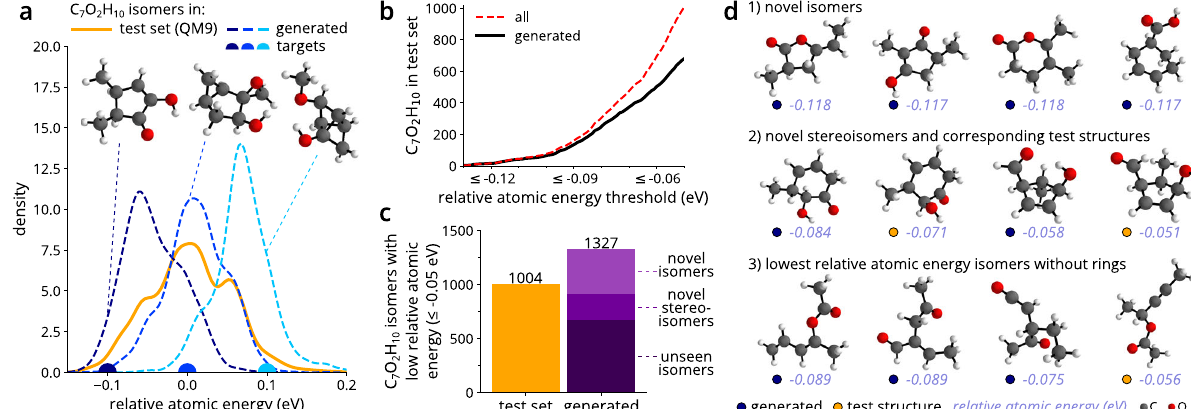
Fig. 4 Discovery of low-energy isomers for an unseen composition. We sample C 7 O 2 H 10 isomers with cG-SchNet conditioned on atomic composition and relative atomic energy (see text for details), where the training dataset was restricted to contain no C 7 O 2 H 10 conformations. a The distribution of the relative atomic energy for C 7 O 2 H 10 isomers in the test set (orange) and for three sets of isomers generated with cG-SchNet (blue curves) when targeting the composition C 7 O 2 H 10 and three different relative atomic energy values as marked with color-matching dots on the x -axis. The generated isomer closest to the respective target is depicted above each curve. b The absolute number of C 7 O 2 H 10 isomers in the test set (red dotted line) for increasing relative atomic energy thresholds. The black solid line shows how many of these were generated by cG-SchNet (target energy − 0.1 eV). c Bar plot of the absolute number of C 7 O 2 H 10 isomers with relative atomic energy ≤ 0.05 eV in the test set (orange) and generated by cG-SchNet (target energy − 0.1 eV, purple). The bar for generated molecules is divided into isomers that can be found in the test set (unseen isomers), isomers that have different stereochemistry but share the same bonding pattern as test set structures (novel stereoisomers), and novel constitutional isomers that are not in QM9 (novel isomers). d Relaxed example low-energy isomers generated by cG-SchNet (target energy − 0.1 eV, blue dots) and structures from the test set (orange dots) along with their relative atomic